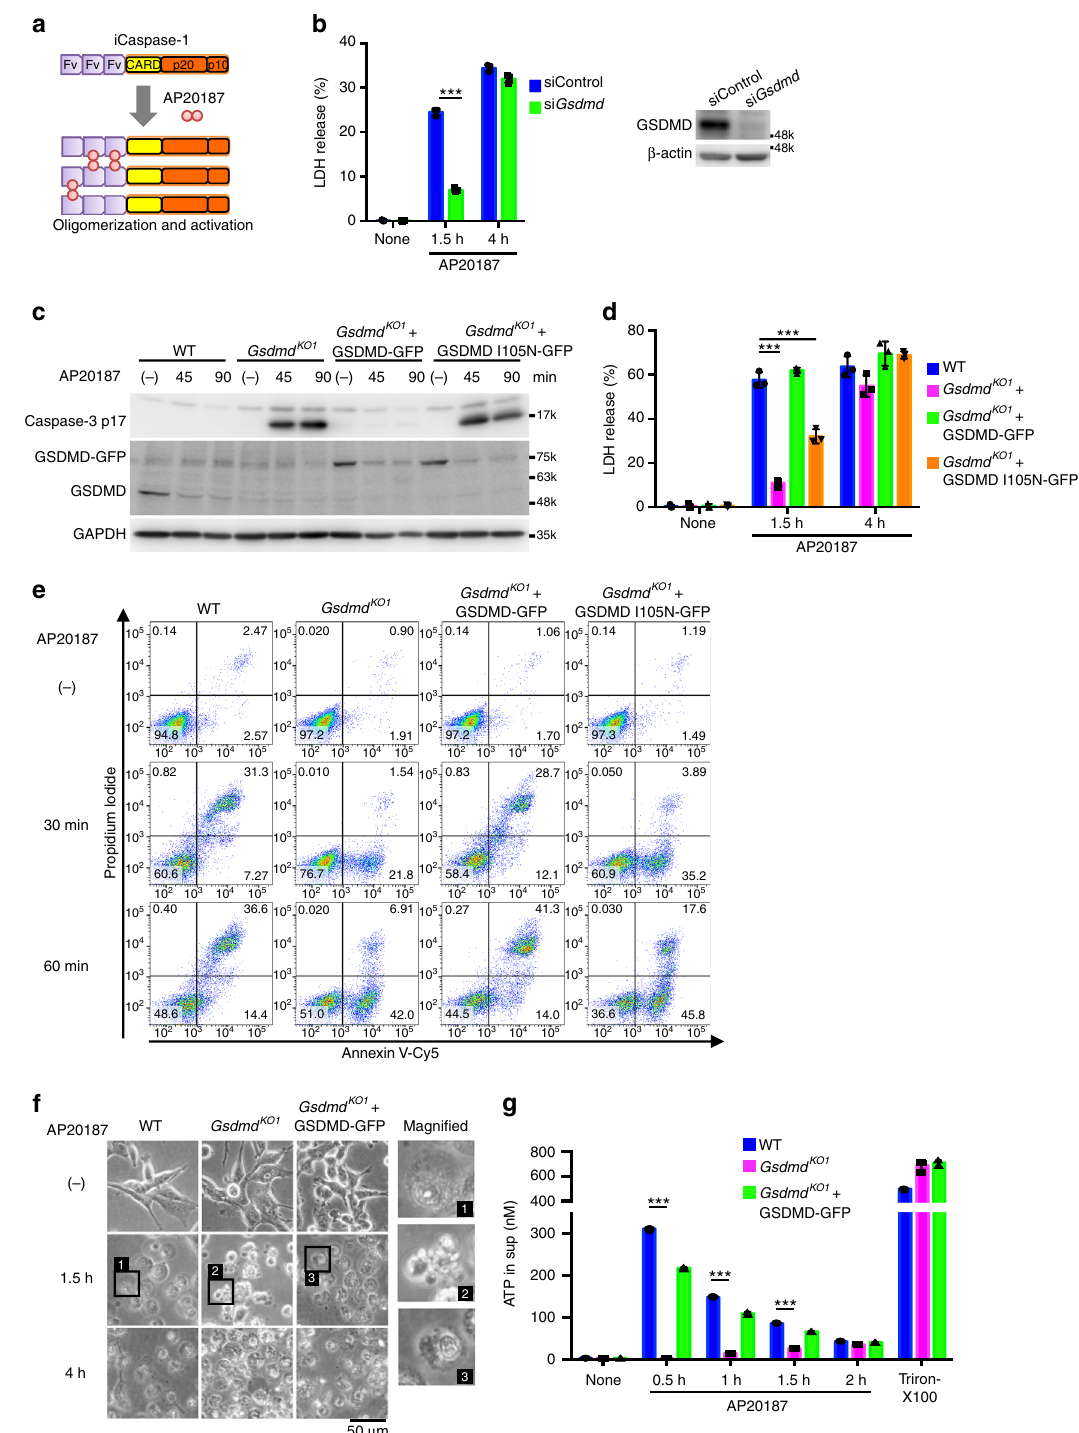
Fig. 2 Caspase-1 initiates apoptosis in the absence of functional GSDMD. a Scheme of the Fv3-mCasp1 protein. AP20187 binds to the Fv domain, leading to the oligomerization and activation of Fv3-mCasp1. b CL26-iCasp1 cells were transfected with control siRNA or Gsdmd siRNA. Two days after transfection, the cells were treated with 50 nM AP20187 for the indicated times, and cell death was monitored by LDH release assay. GSDMD was detected by Western blotting. c – g CL26-iCasp1 cells of the indicated genotypes transduced or not transduced with GSDMD-GFP or GSDMD I105N-GFP were treated with 50 nM AP20187. Cleaved caspase-3 was detected by Western blotting ( c ). LDH release ( d ). PI uptake and PS exposure analyzed by fl ow cytometry (e, n = 2). Microscopic images ( f ). ATP in culture supernatants was measured ( g ). In b , d , and g , graphs depict the mean ± SD of triplicate cultures, and individual data values are plotted. Statistical signi fi cance was determined using an unpaired Student ’ s t -test ( b ) or Bonferroni ’ s multiple comparisons test ( d , g ). *** p < 0.001. Data are from one representative of two ( e ), three ( c , f , and g ), or four ( b , d ) independent experiments with similar results. Source data are provided as a Source Data fi le. (See also Supplementary Fig.